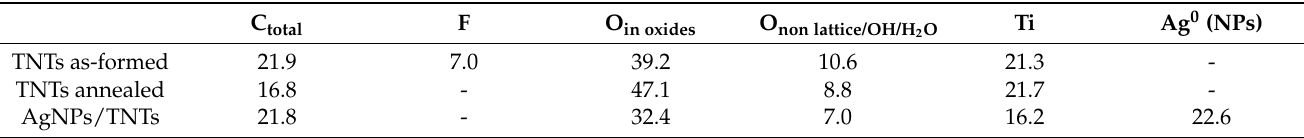
Table 2. Chemical composition (atomic%) of as-formed TNTs, annealed TNTs, and AgNPs/TNTs platform calculated from the XPS